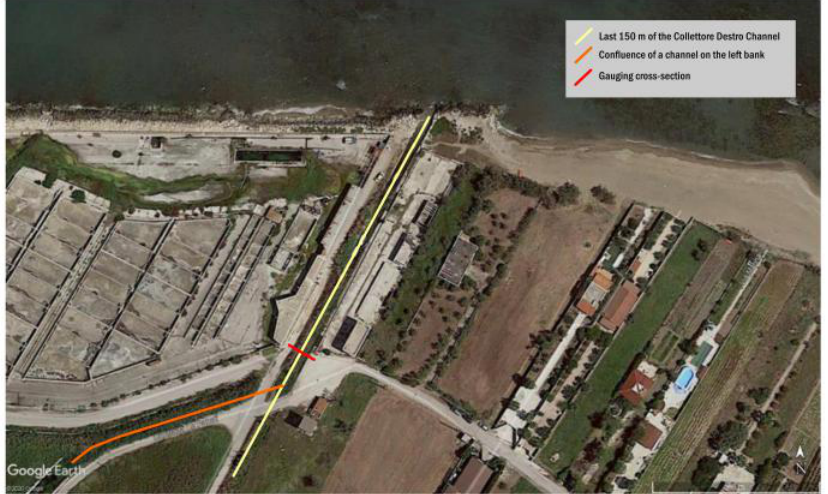
Figure 4. Aerial picture of the study area showing the last stretch of the “Collettore Destro” drainage channel and the location of the gauging cross-section during the monitoring of